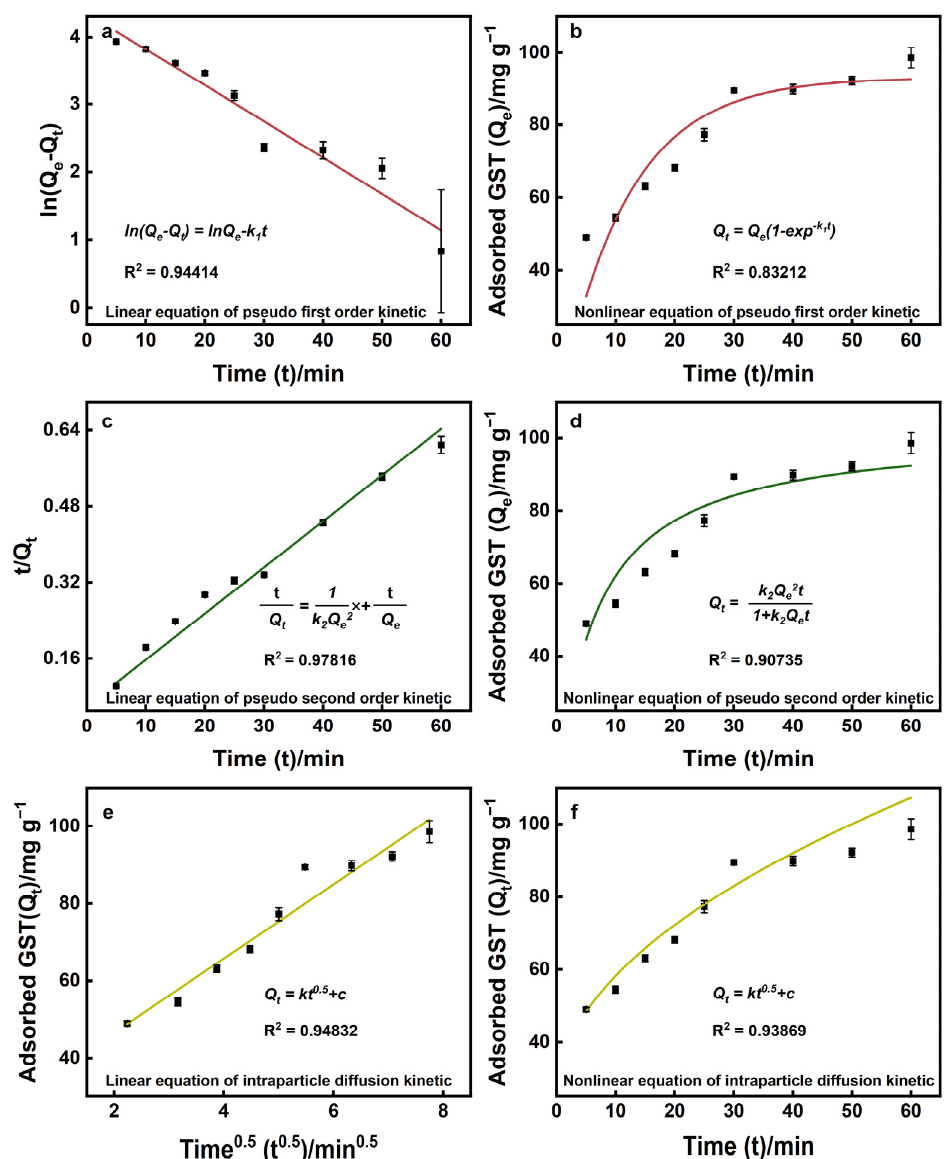
Figure 6. ( a ) The linear fit result of pseudo first order kinetic model. ( b ) The nonlinear fit result of pseudo first order kinetic model. ( c ) The linear fit result of pseudo second order kinetic model. ( d ) The nonlinear fit result of pseudo second order kinetic model. ( e ) The linear fit result of intraparticle diffusion kinetic model. ( f ) The nonlinear fit result of intraparticle diffusion kinetic model. GST solution: 1.0 mL, 100 mg L − 1 ; Mass of adsorbent: 1.0 mg; pH 6.5.